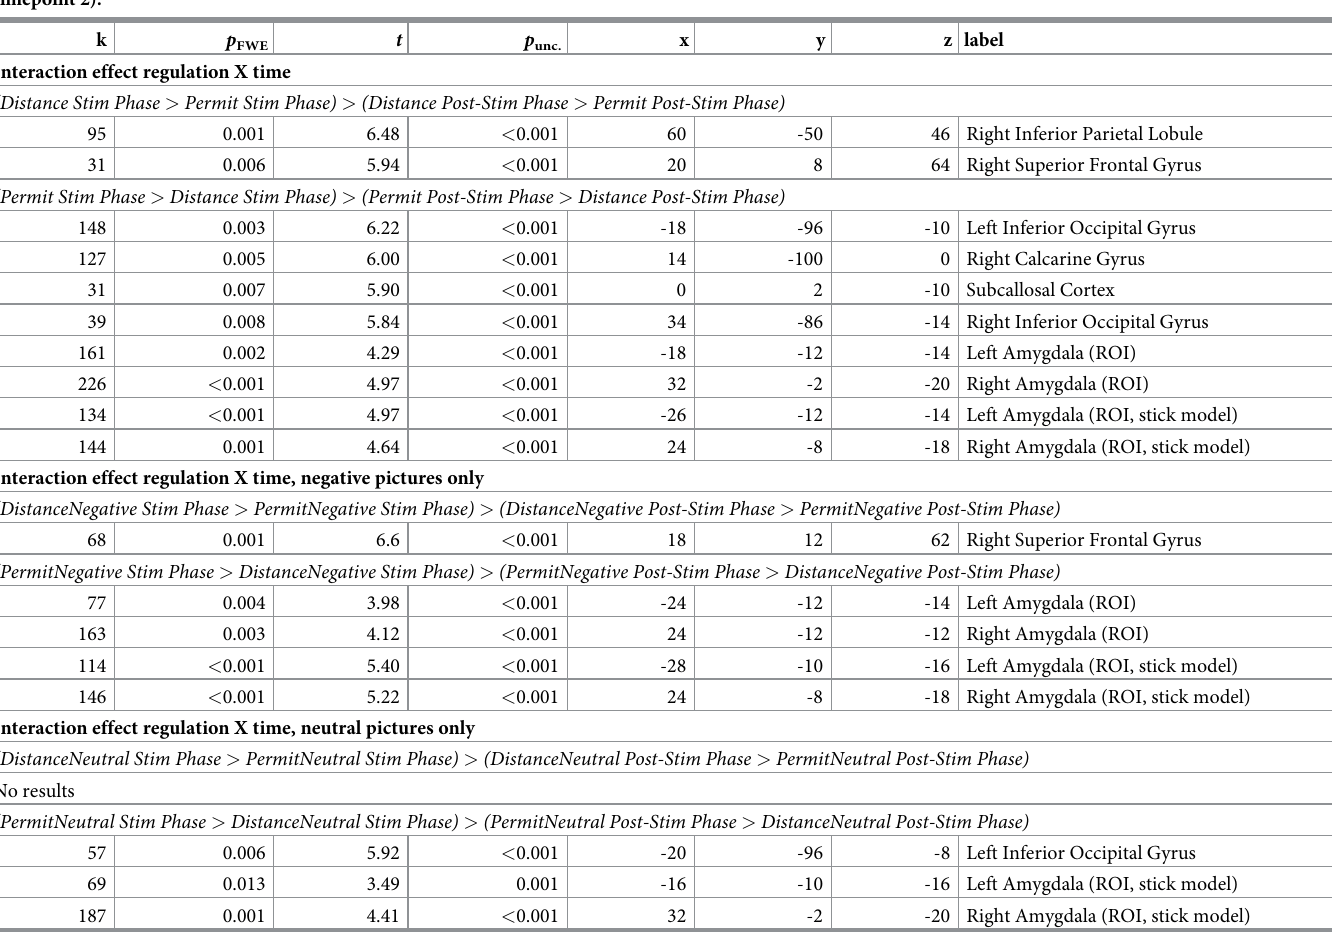
Table 3. Immediate aftereffects of emotion regulation (interaction effects of regulation (permit, distance) and time (stimulation/timepoint 1, post-stimulation/ timepoint